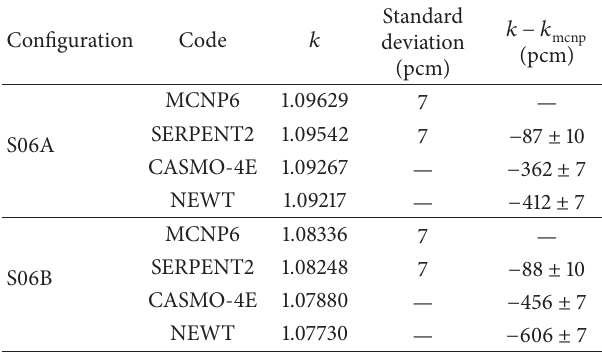
Table 2: The eigenvalue of DIMPLE S06 criticality benchmark by direct modeling in